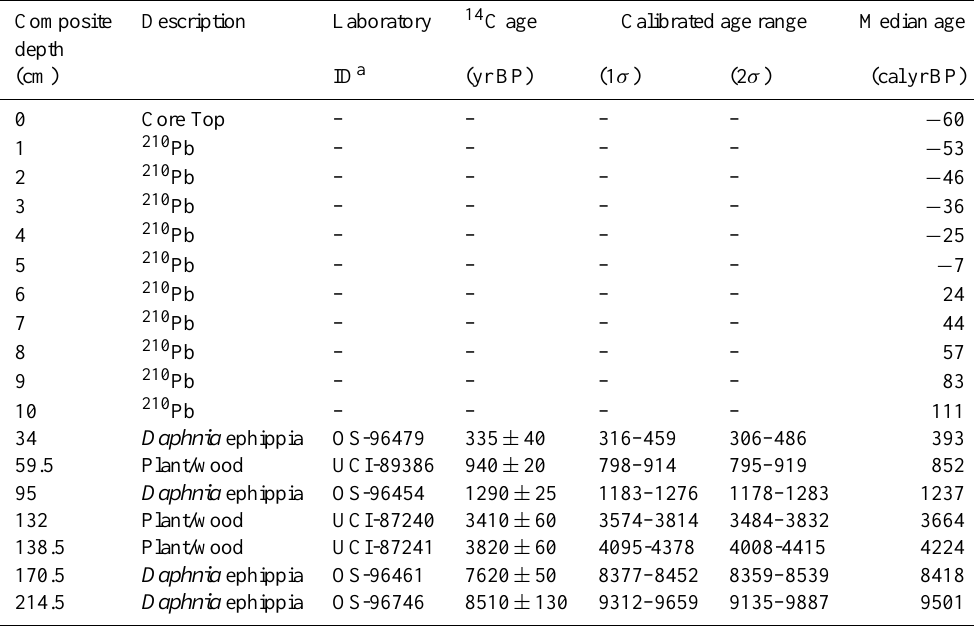
Figure 2. Magnetic susceptibility profile, percent sand, and mass accumulation rate (MAR) shown next to the age–depth model for the composite Kulusuk Lake record. The four lithostratigraphic units and the corresponding sedimentation rates are shown. A dash line marks the period below the last radiocarbon age (9.5 calka BP) where rates of sedimentation are extrapolated. Table 1. Geochronologic data for the Kulusuk Lake